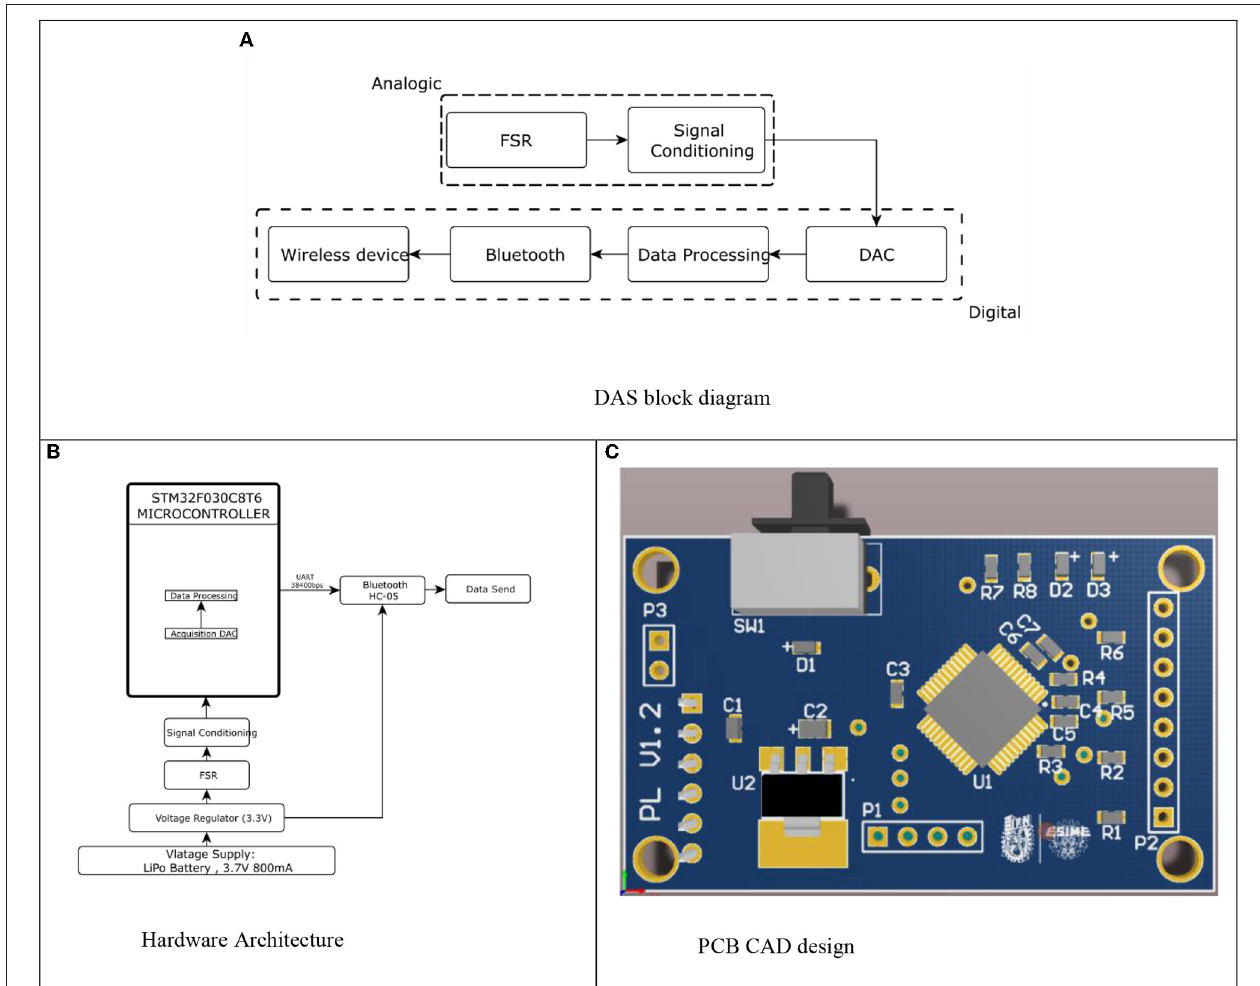
FIGURE 5 | Data acquisition system. (A) DAS block diagram. (B) Hardware Architecture. (C) PCB CAD